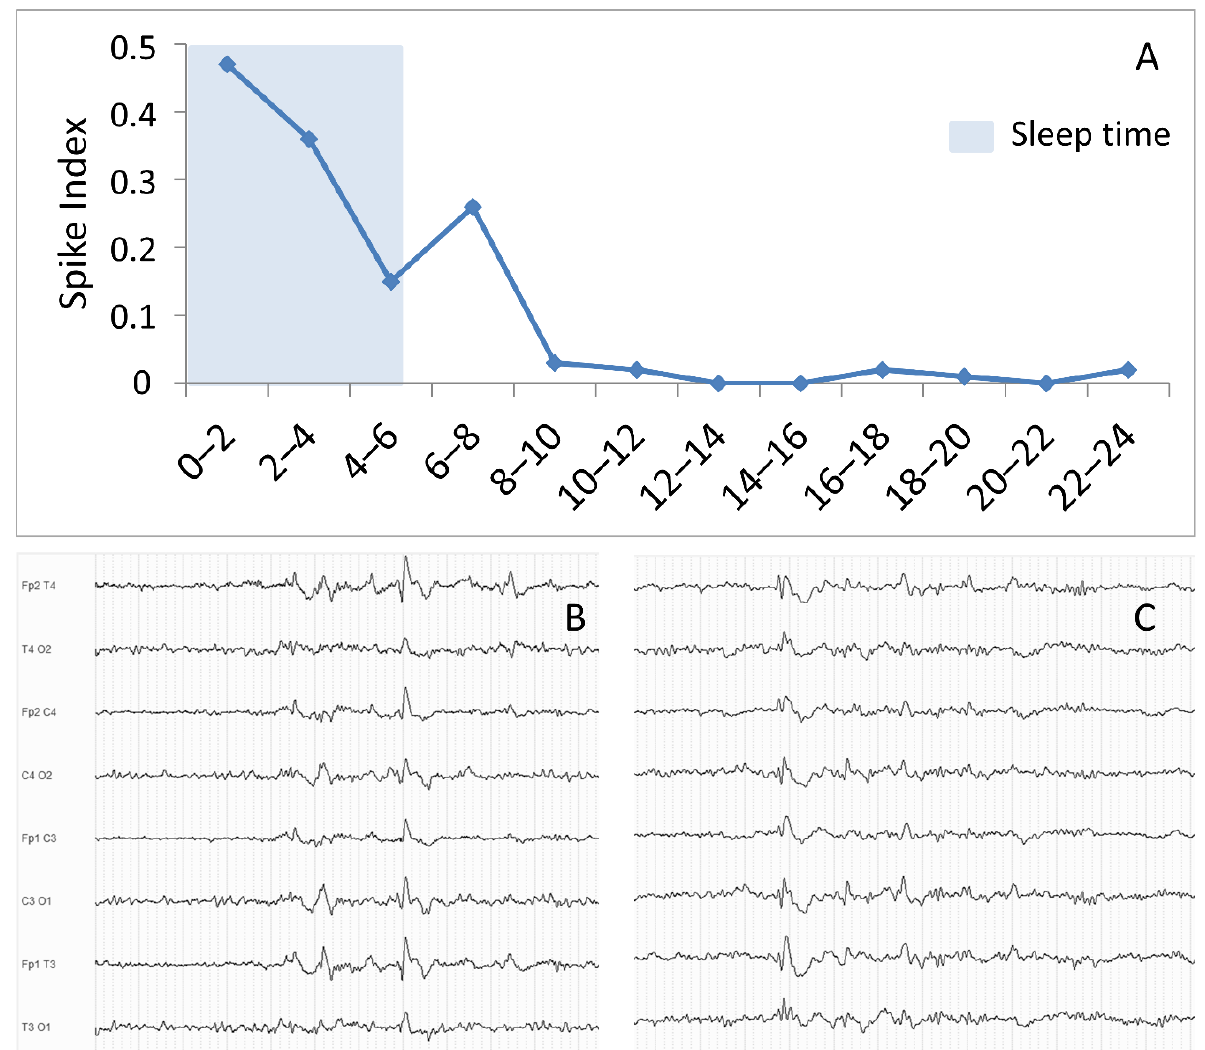
Figure 1. Circadian distribution and morphology of epileptiform discharges. Panel ( A ): Distribution of epileptiform discharges (ED), measured as by spike index, during a 24-h EEG recording in a sample patient with idiopathic generalized epilepsy. The blue shaded area represents the sleep period. Spike index was calculated as (duration of ED -measured in minutes — occurring during a 2-h interval/120 min) × 100. Panel ( B , C ): examples of ED in the midst of sleep physiological figures.